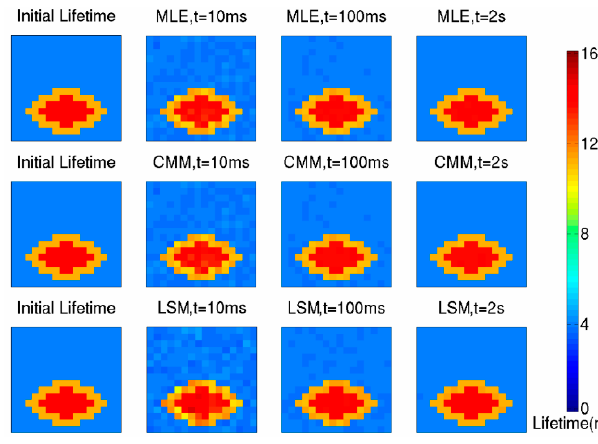
Figure 13. The simulation result of No. 1 picture.